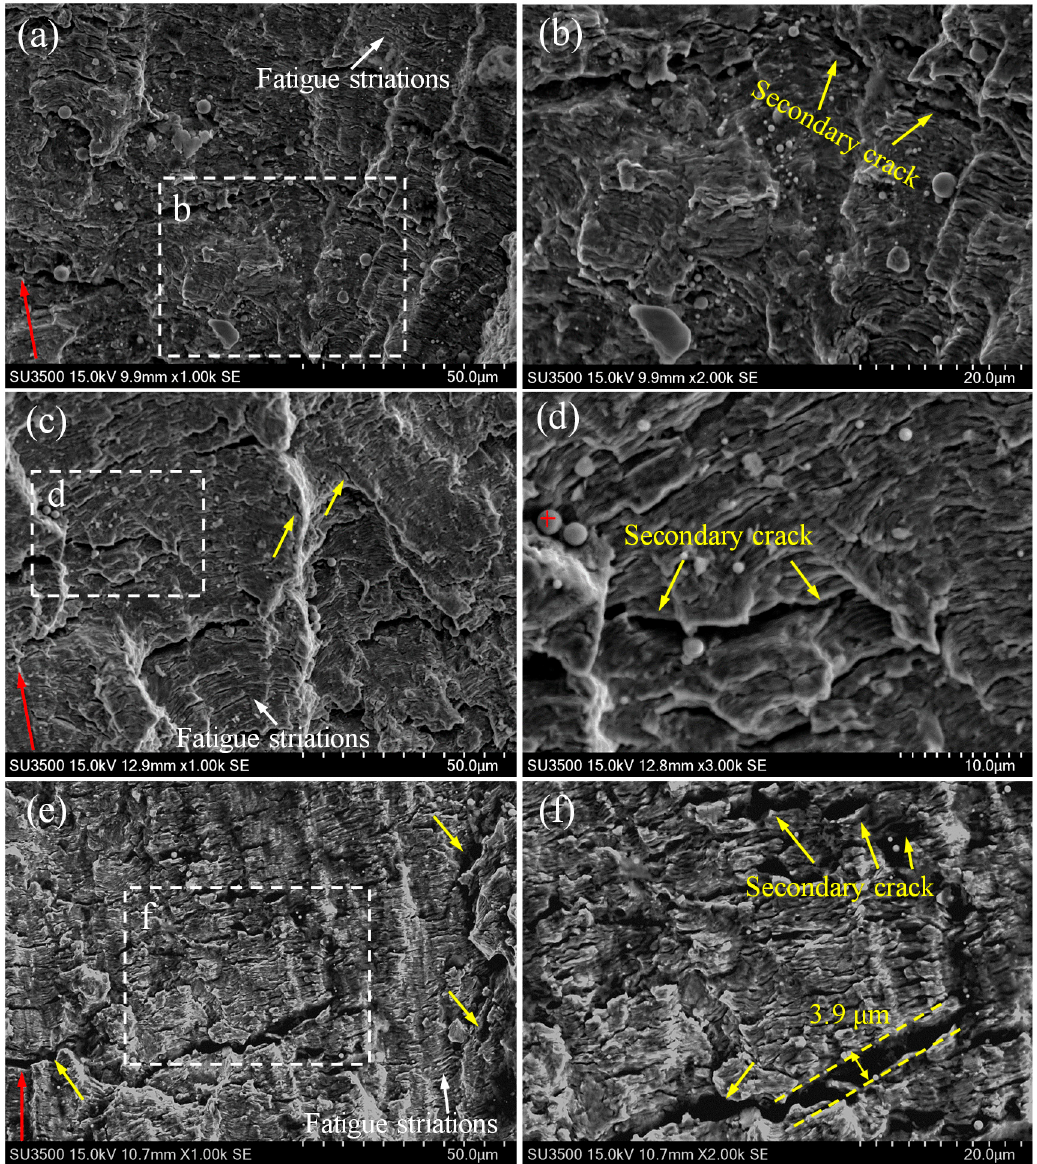
Figure 6. Fatigue fracture surfaces of ( a , b ) BM, ( c , d ) HAZ and ( e , f ) WM specimens at Δ K value of approximately 55 MPa·m 1/2 . Typically, the red arrows represent the crack growth direction, the white arrows represent the fatigue striations, and the yellow arrows indicate the secondary cracks. Some secondary cracks perpendicular to fatigue striations can be found in ( c ) and ( f ).